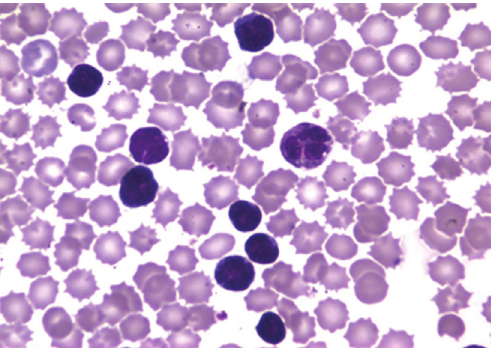
Figure 1: Peripheral blood smear showing leukemic cells with varying cell morphologies (including CLL-like small lymphocytes).